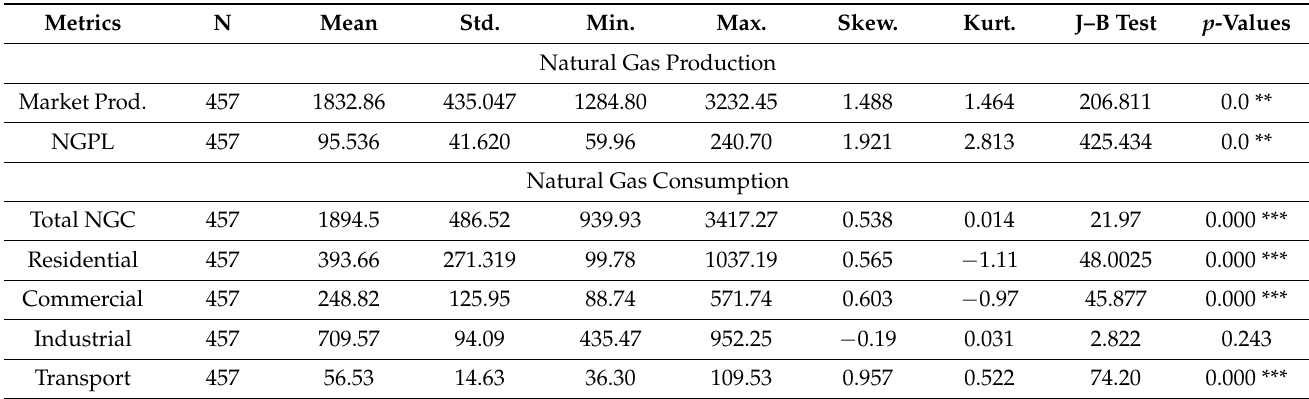
Table 1. Statistical summary of descriptions for natural gas production and consumption.